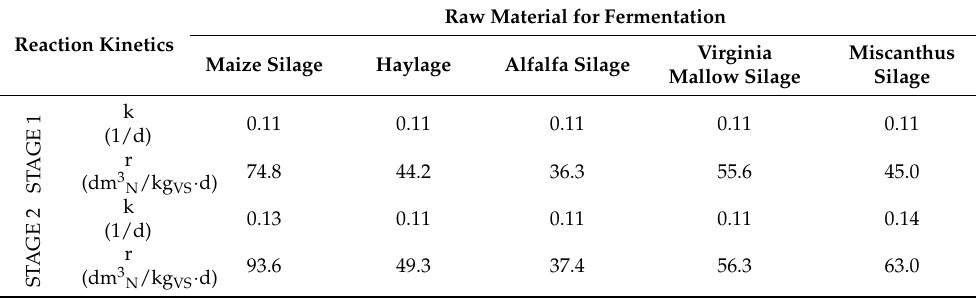
Table 5. Reaction kinetics (k is the rate constant, r is the rate coefficient) of biogas production from energy